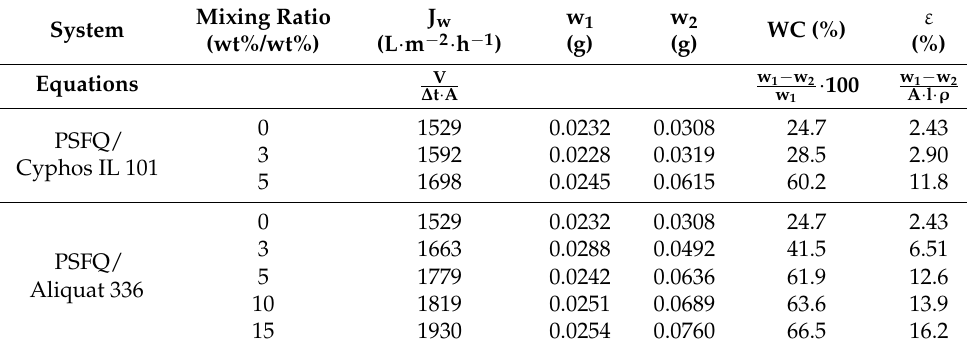
Table 1. The parameters of the studied membranes *.